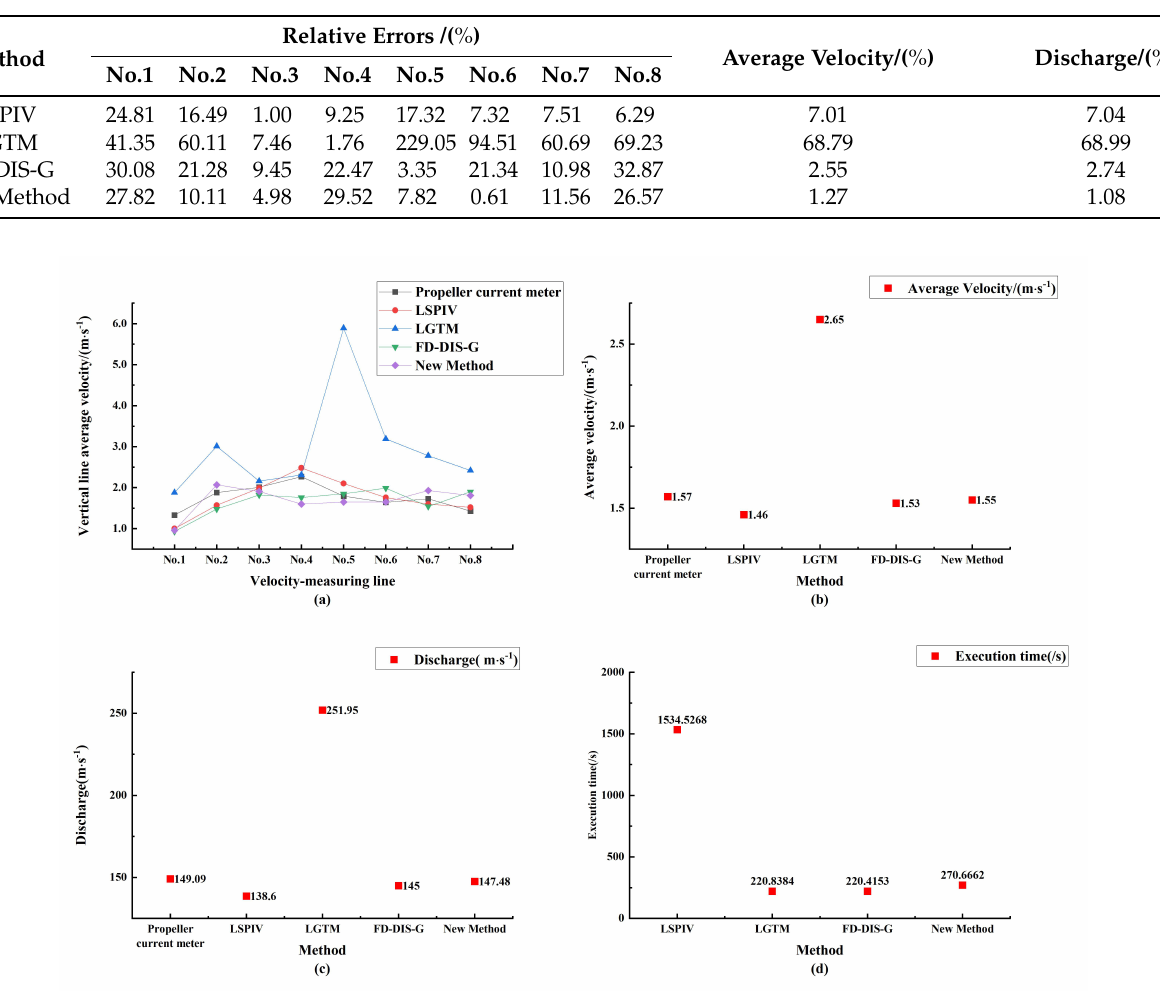
Table 7. Relative errors of the vertical line average velocity of four methods.